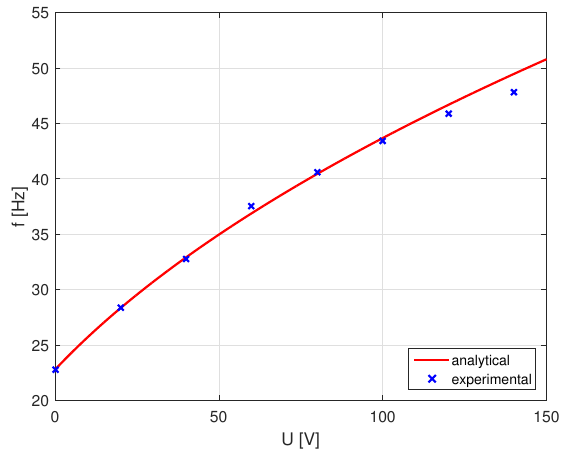
Figure 10. Comparison of resonance frequencies (analytical and experimental) for the electrical tuning of the adaptive vibration